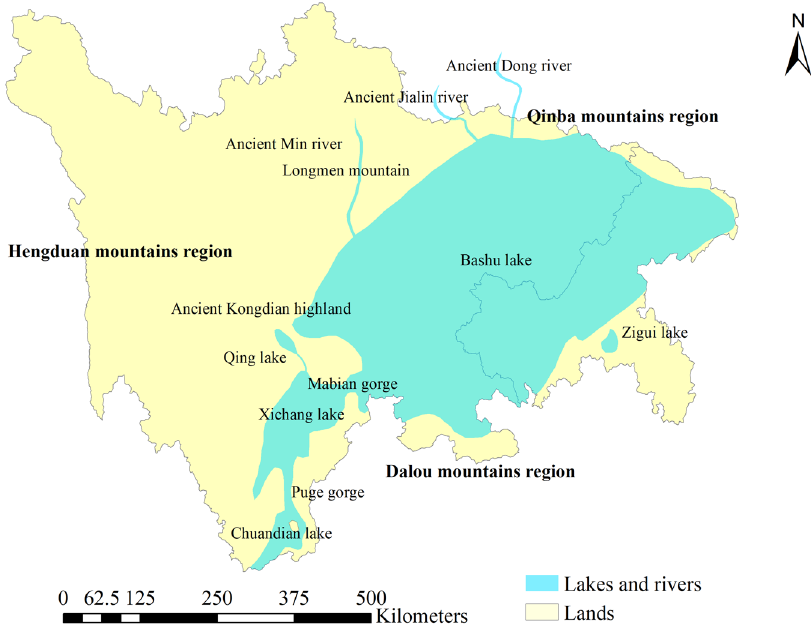
Figure 2. Schematic diagram of the Jurassic palaeoenvironment of the Sichuan Basin.